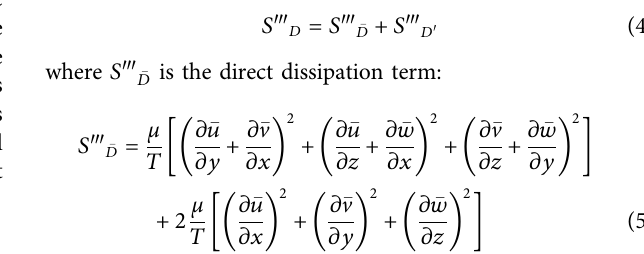
Figure 1 . The structural design parameters of the pump are shown in Table 1 .